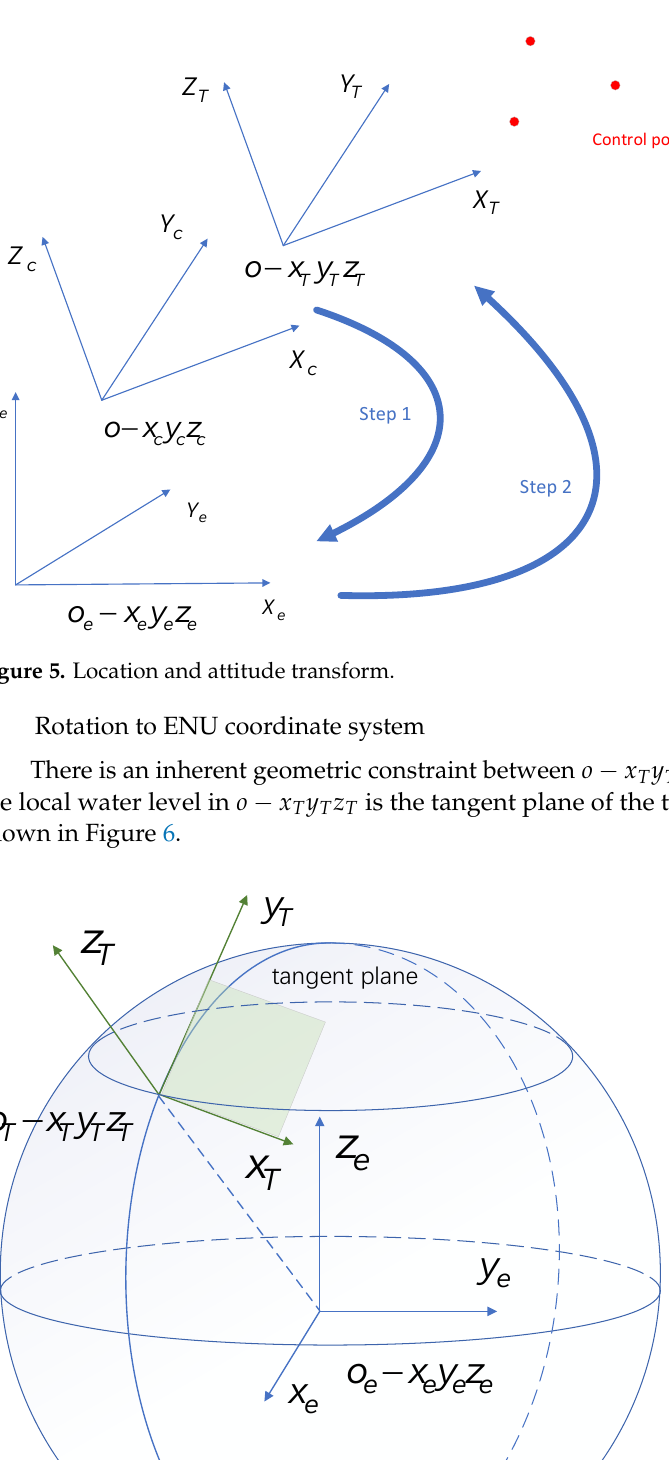
− x e y e z e T y T z T and o e